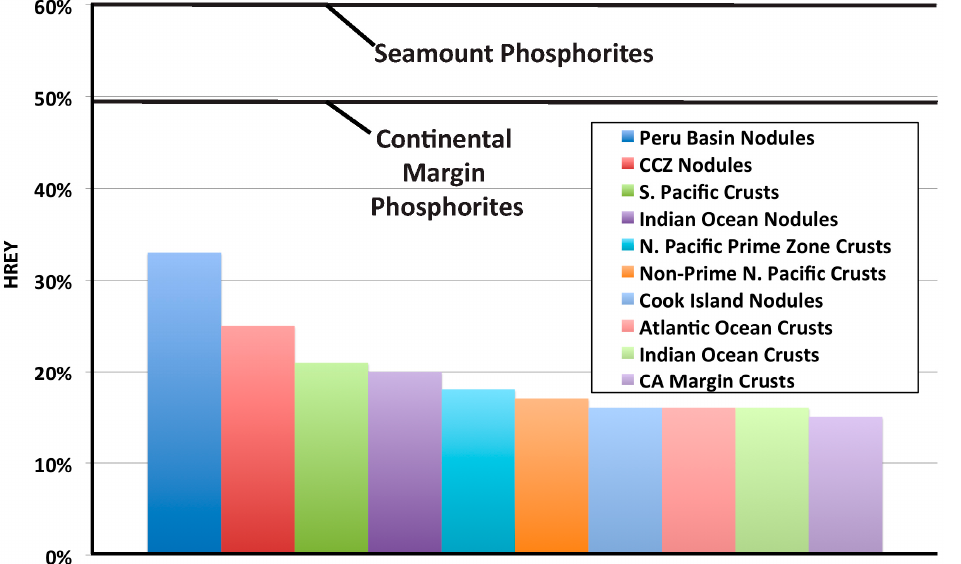
Figure 7. Comparison of mean total HREY contents of ferromanganese deposits with seamount and continental margin phosphorites. Minerals 2016 , 6 , 88